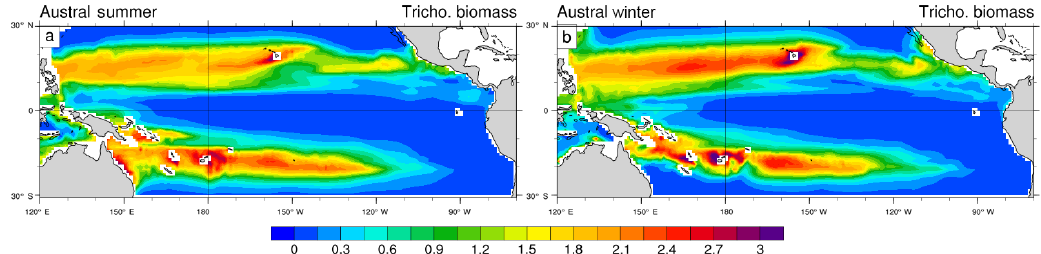
Figure 6. Trichodesmium biomass (mmolCm − 2 ) in (a) austral summer and (b) austral winter, integrated over the top 100m of the